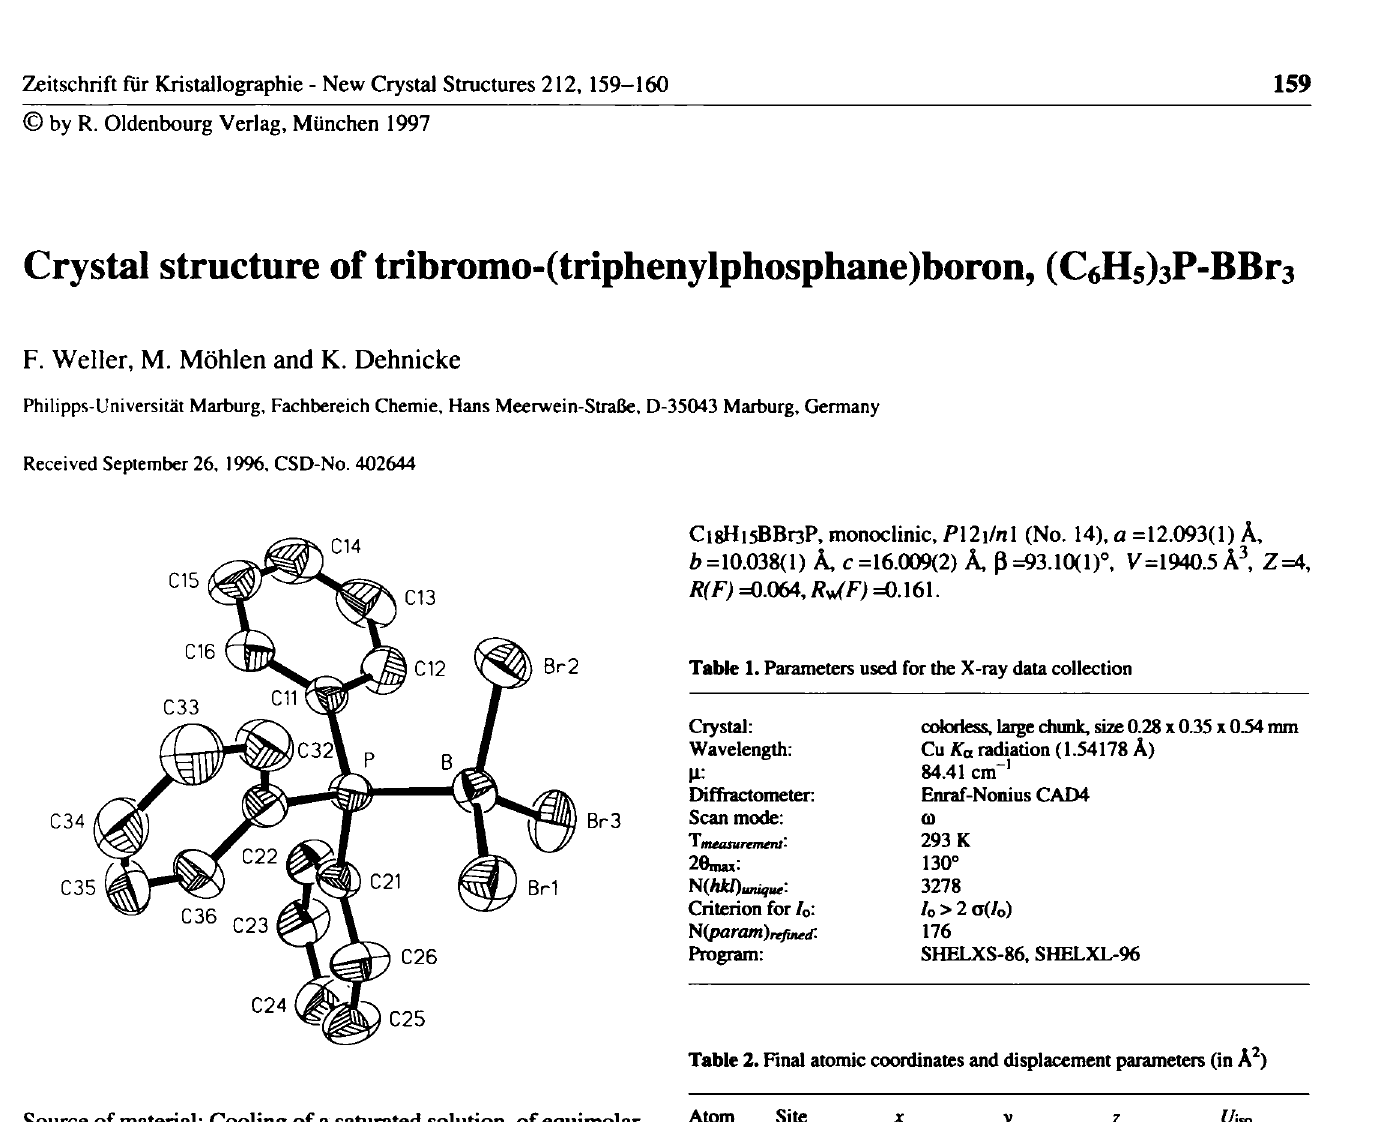
Table 2. Final atomic coordinates and displacement parameters (in A 2 )